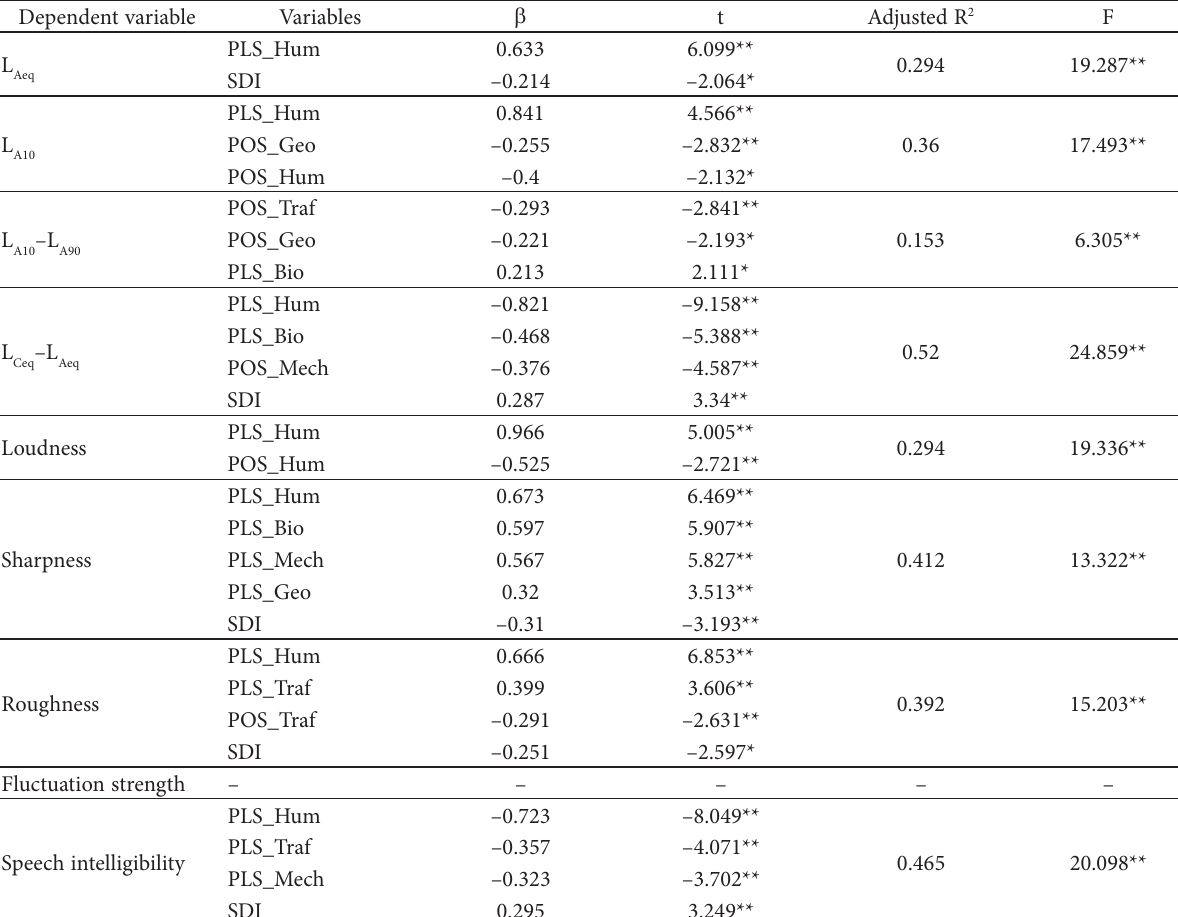
Table 4. Regression analysis results between each of the physical and psychoacoustic parameters and soundscape composition parameters and, where no relationship was shown are marked with “—”; * p < 0.05, ** p <